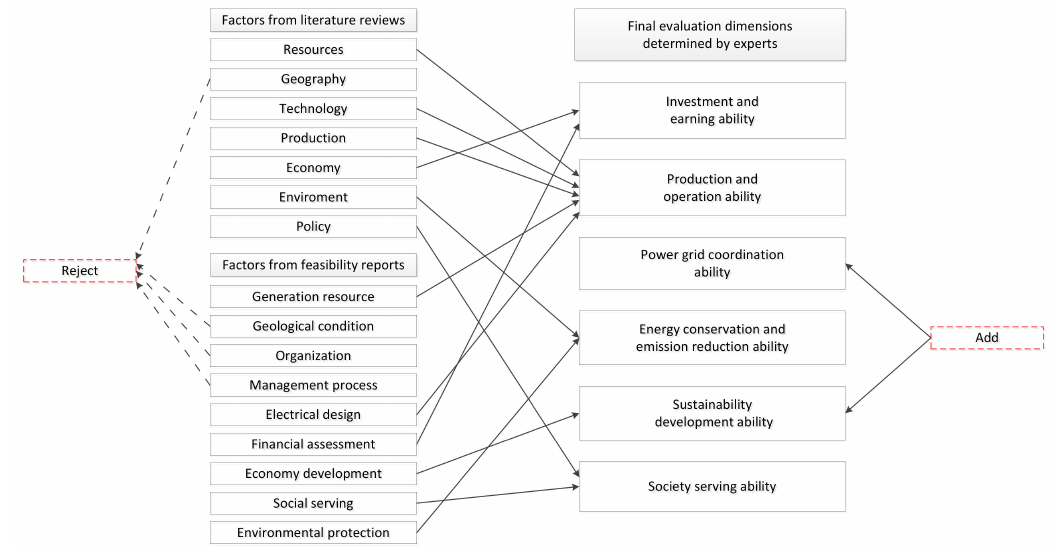
Figure 3. Evaluation indexes selection by